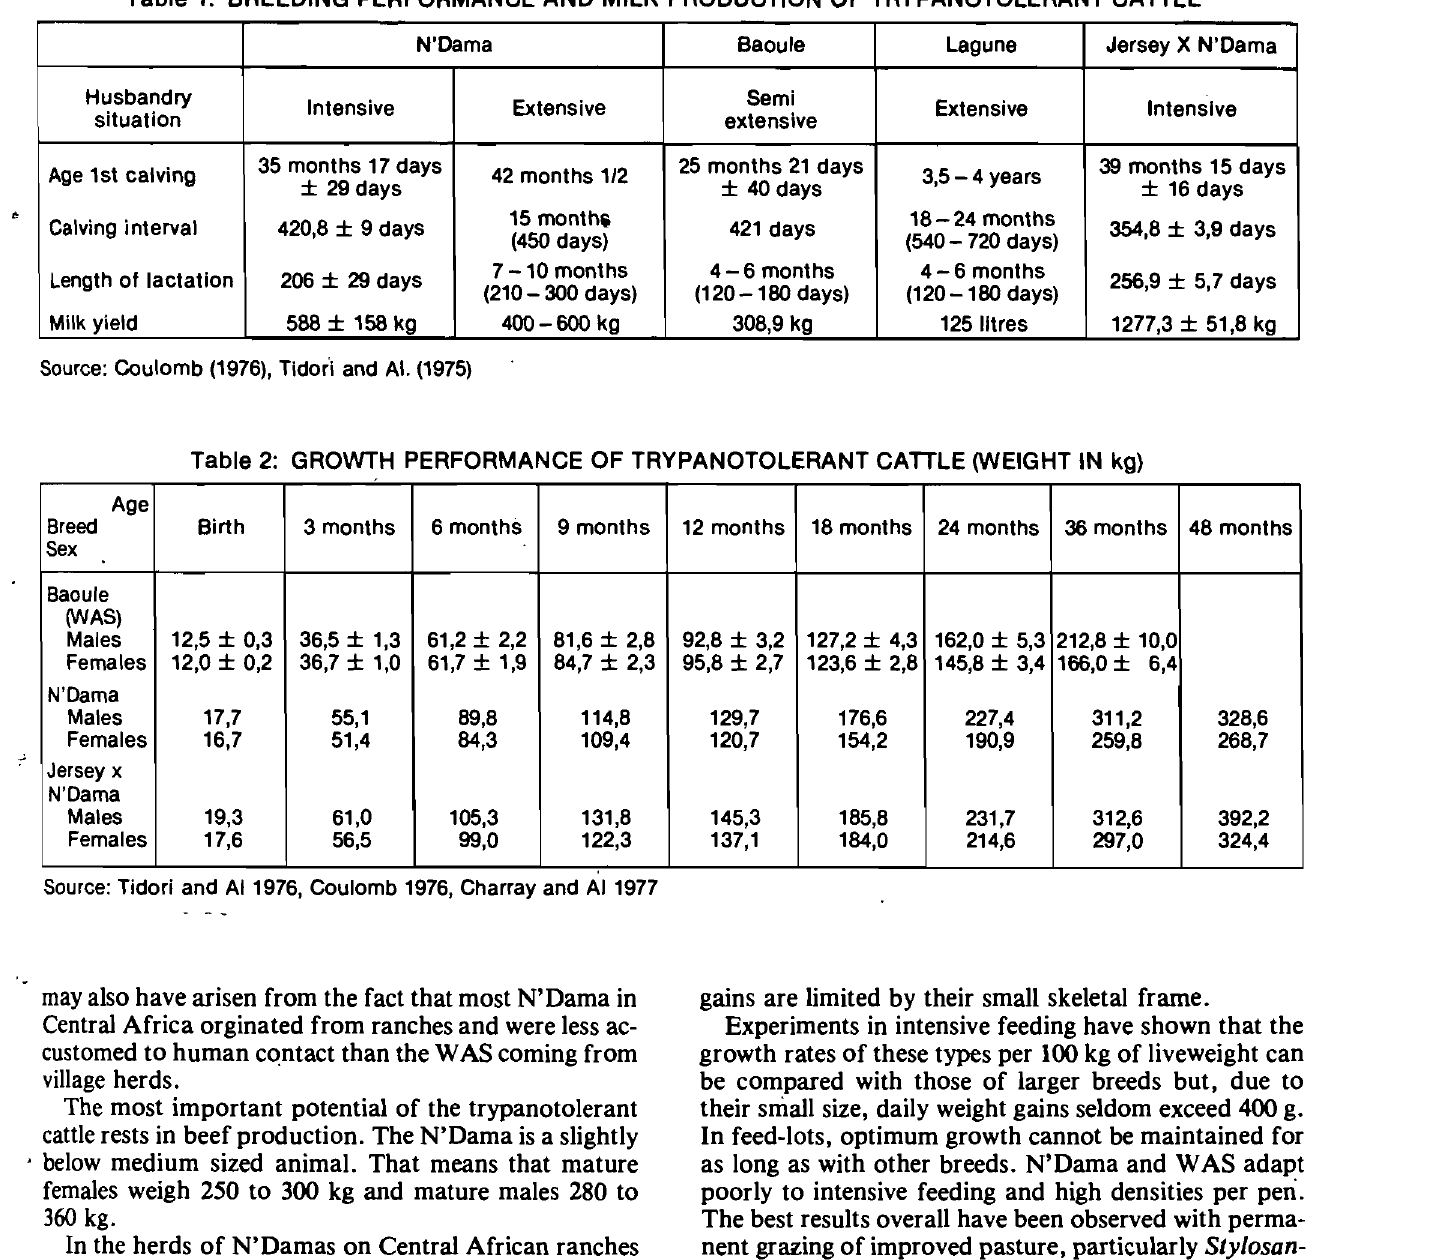
Husbandry Intensive extensive Semi